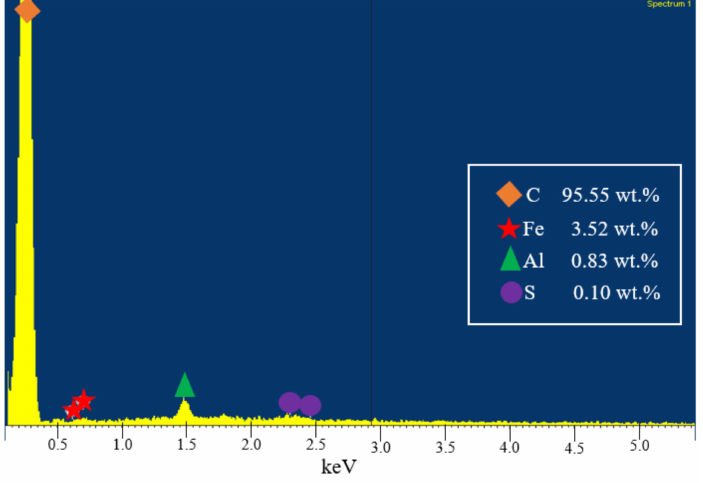
Figure 4. EDX spectra of MWCNTs.